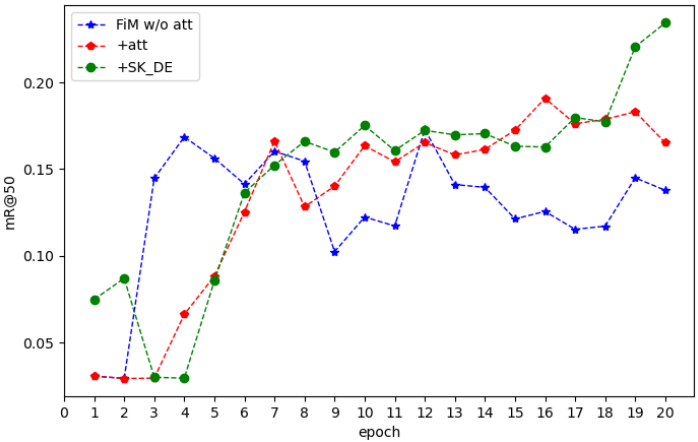
Figure 4. The trends of mR@50 with different structures of RSSGG_CS in the first 20